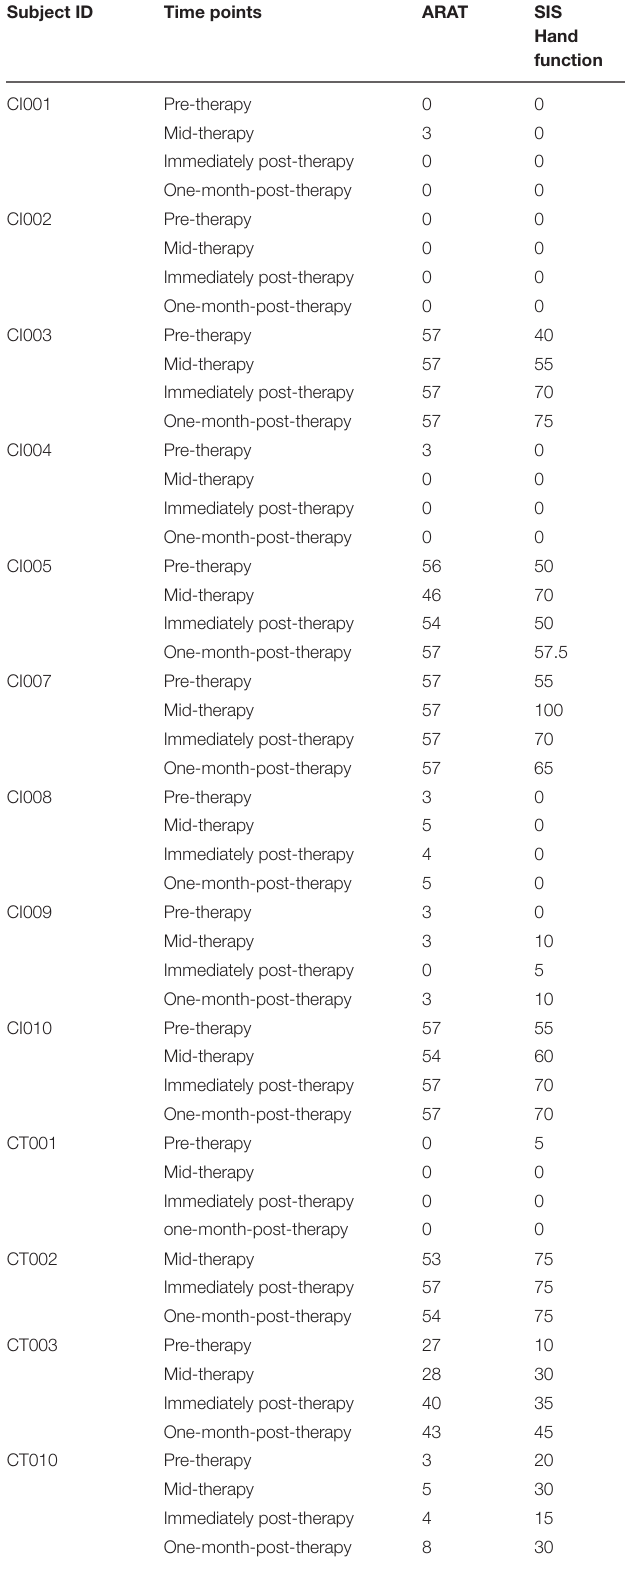
TABLE 2 | Clinical motor outcome assessments of the stroke-affected limb.